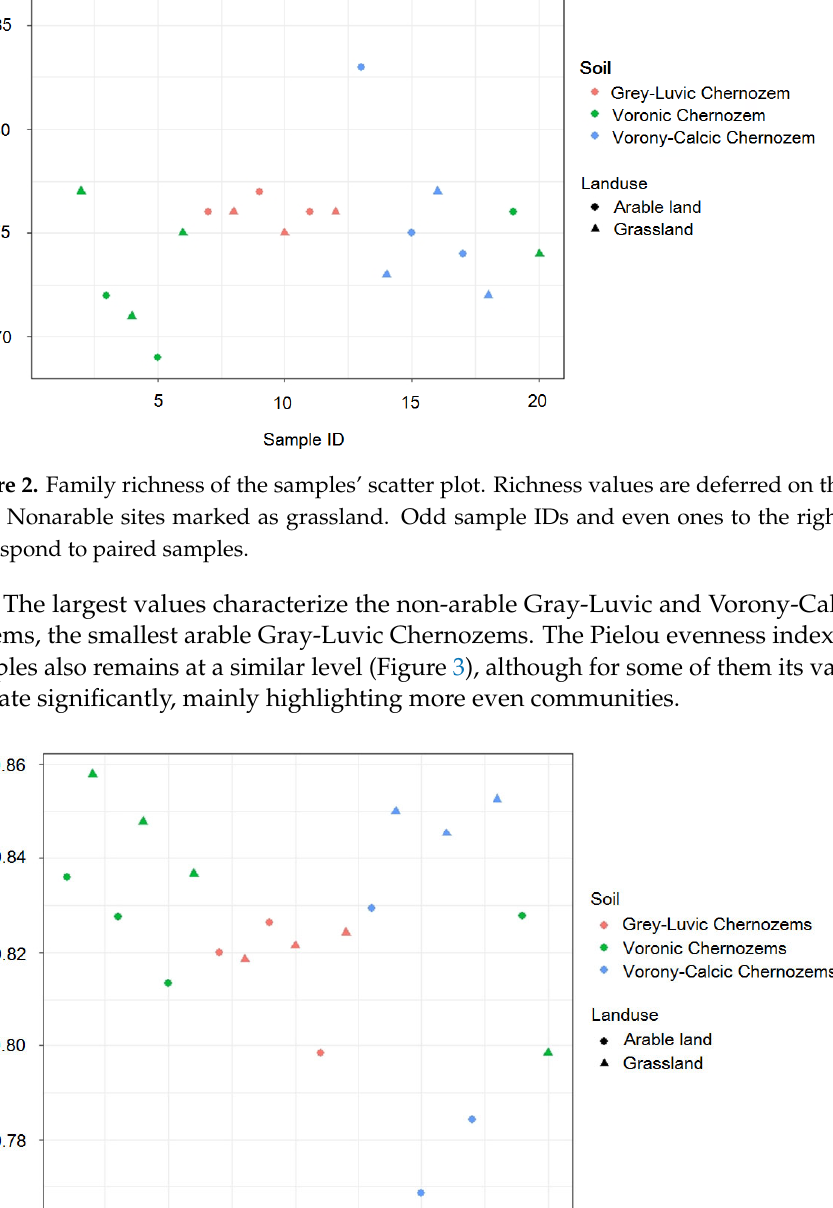
Table 2. Indexes of diversity for arable and nonarable sites and for three subtypes of chernozem.